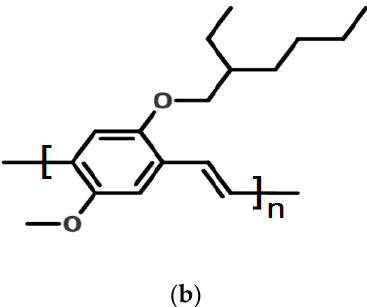
Figure 9. The molecular structures of ( a ) PFO and ( b ) MEH-PPV.